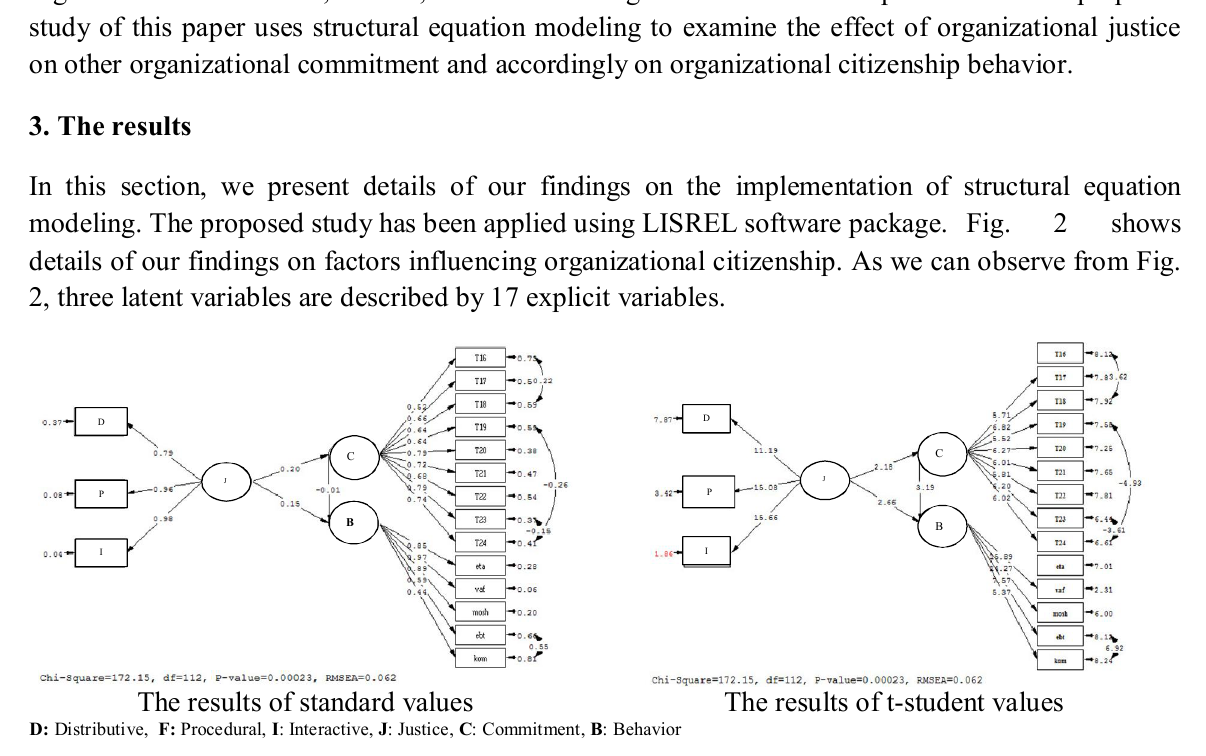
Fig. 2. The results of structural equation modeling on factors influencing organizational